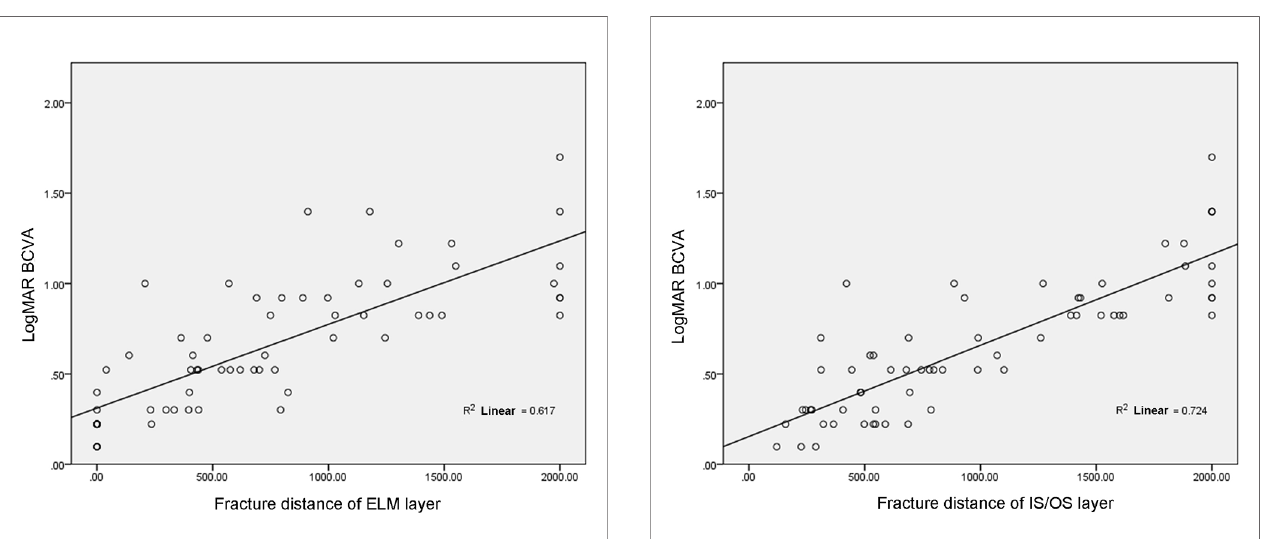
FIGURE 2 | Correlation between fracture distance of ELM layer and LogMAR